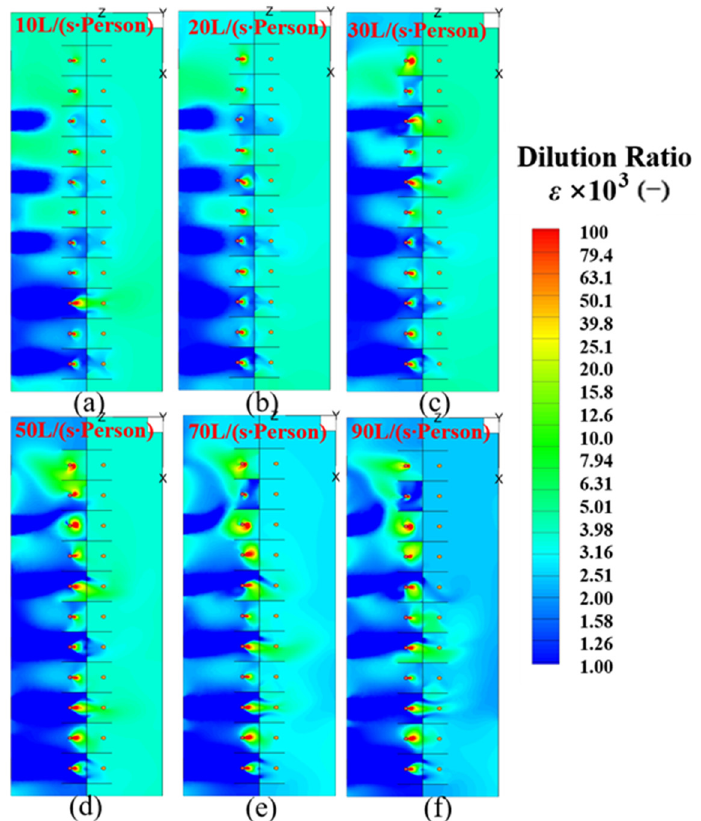
Figure 13. Dilution ratio distribution at the breathing height (y = 1.1 m) under the SEFV-W with different ventilation rates: ( a ) 10 L/(s · Person); ( b ) 20 L/(s · Person); ( c ) 30 L/(s · Person); ( d ) 50 L/(s · Person); ( e ) 70 L/(s · Person); ( f ) 90 L/(s · Person).